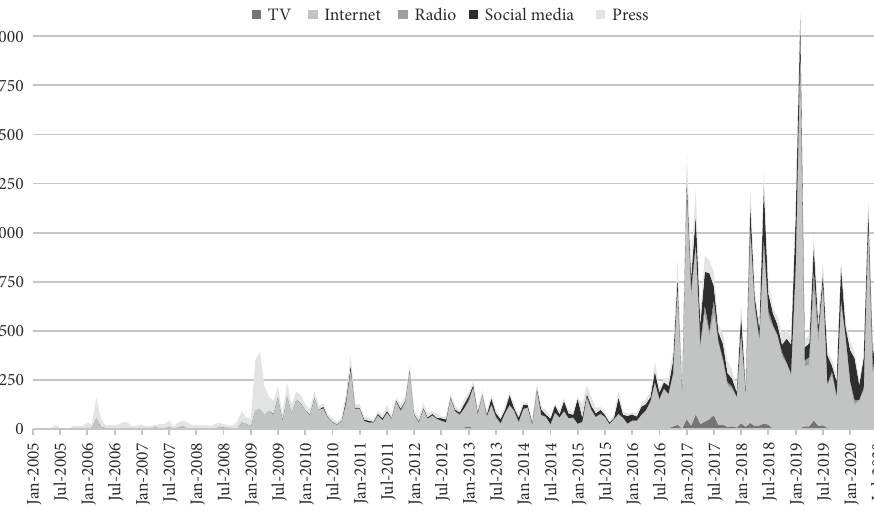
Figure 1. Number of media releases on protectionism in the Polish media between January 2005 and December 2020 (source: authors’ own elaboration based on data from the information agency,